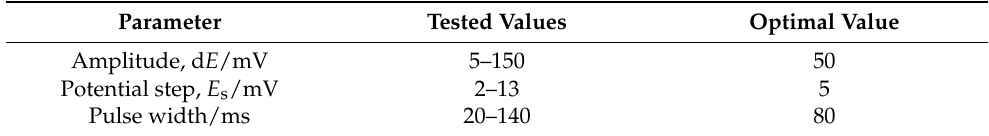
Table 1. Optimization of DPV